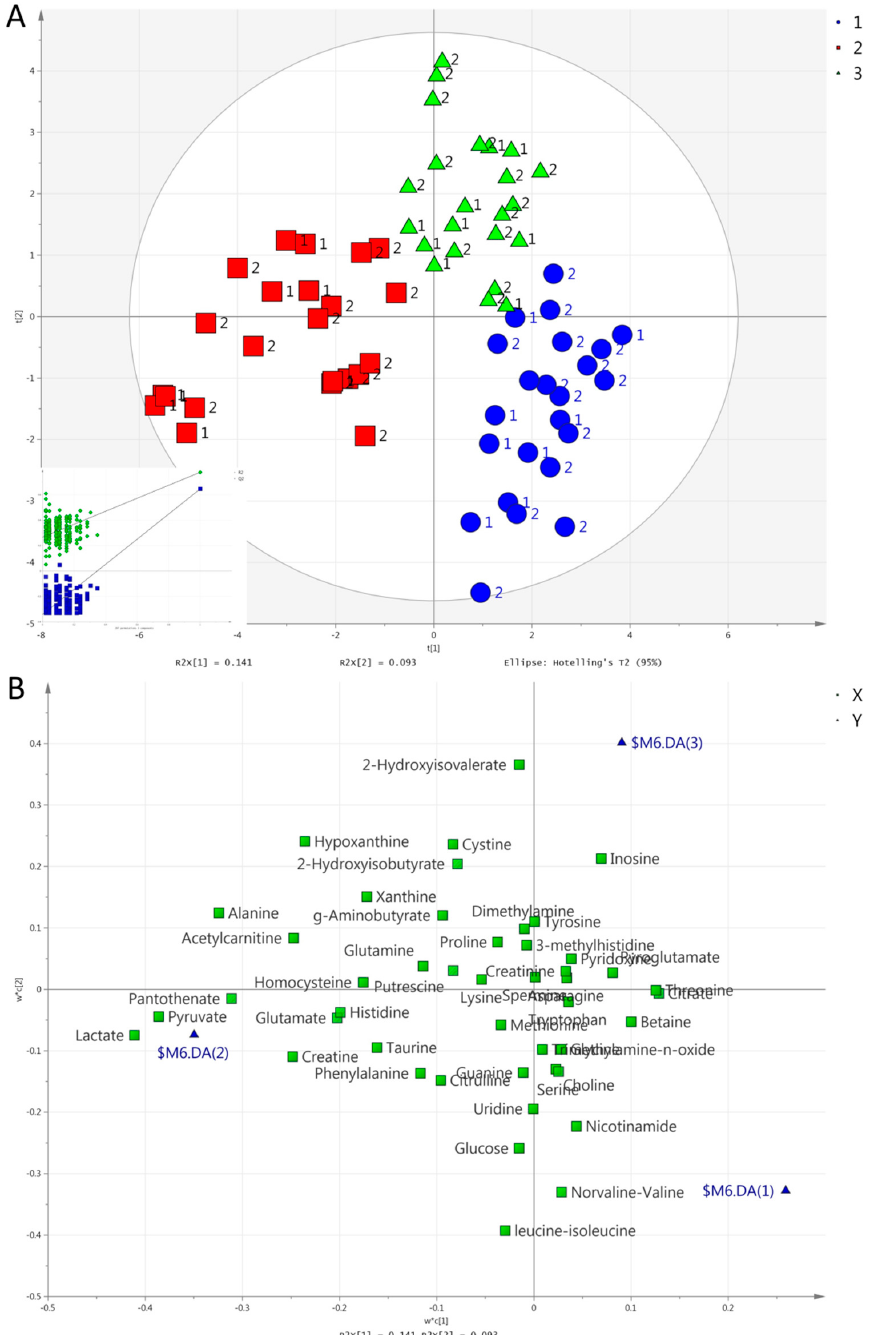
Figure 6. ( A ). Score plot concerning serum samples for the PLS-DA model for RE: 0 h (blue circles), 1 h (red squares), 2 h (green triangles). Inserts (subfigure) are permutation plots. The number 1 is used for the MetS group and 2 for the Healthy group. ( B ). Loading plot for the respective PLS-DA model. Blue triangles represent 0 h (1), 1 h (2), and 2 h (3).